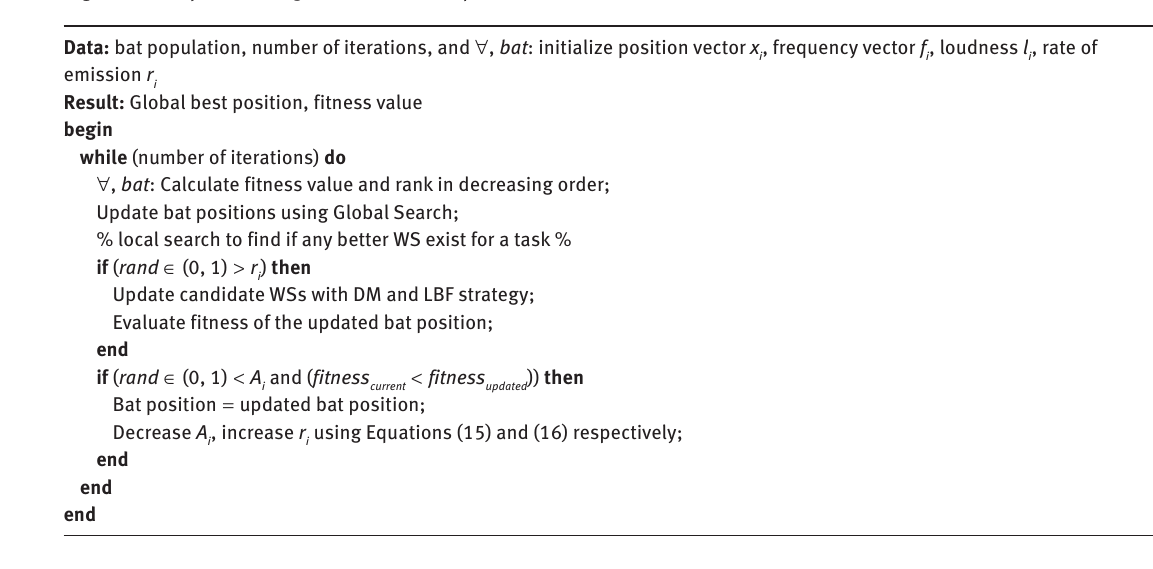
Algorithm 2: Hybrid BAT Algorithm for WS